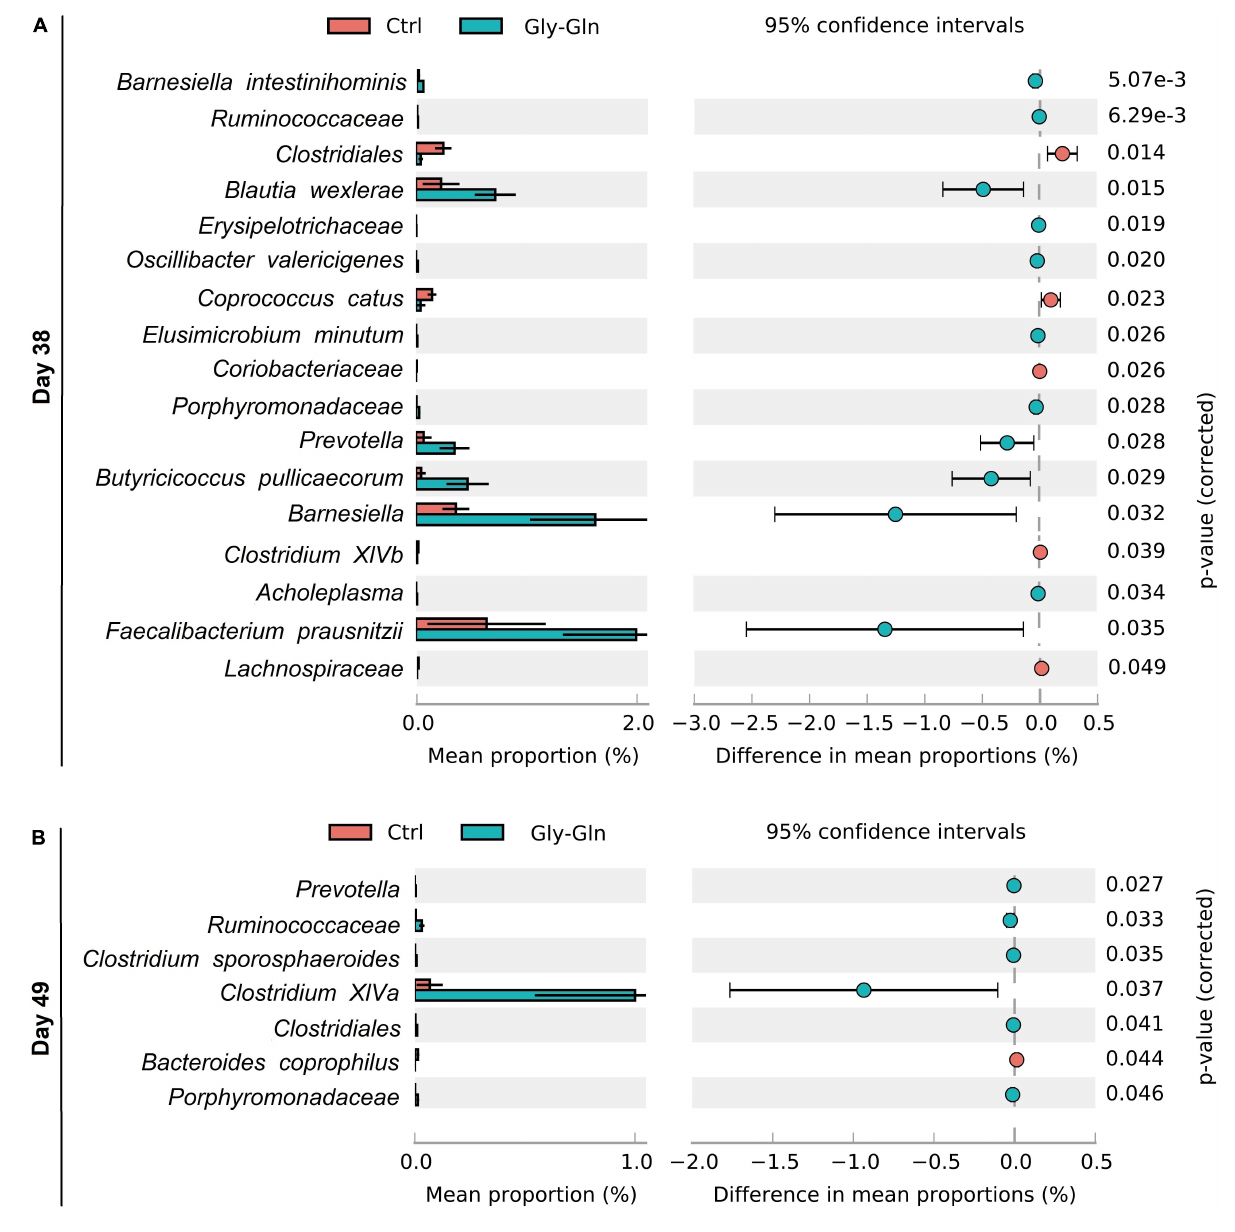
FIGURE 5 | Effect of dietary Gly-Gln supplementation on the relative abundance of gut microbiota at species-level. The relative abundance of different species on day 38 (A) and day 49 (B)